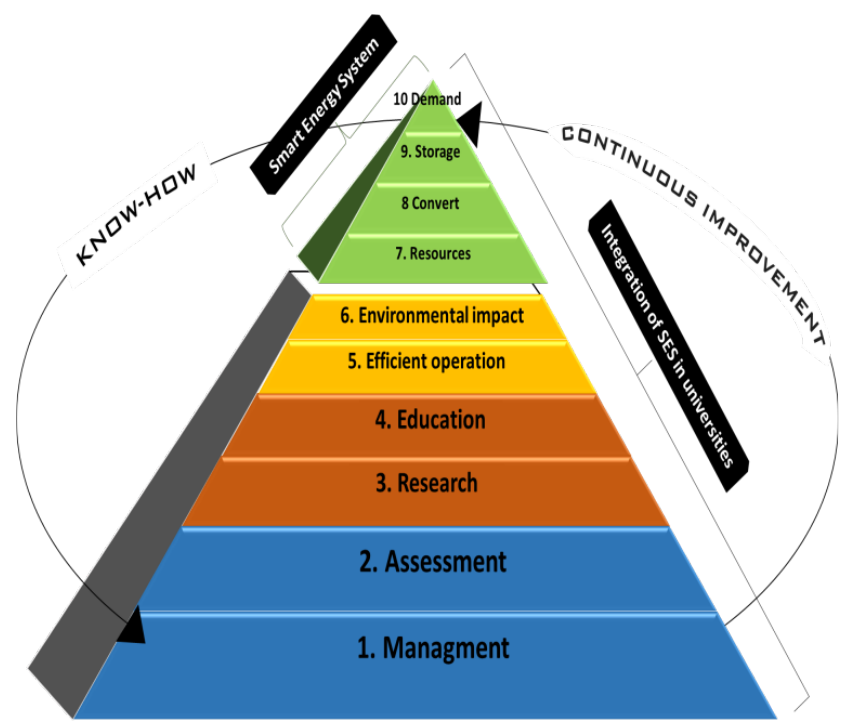
Figure 3. KPI framework for SESs in sustainable universities.